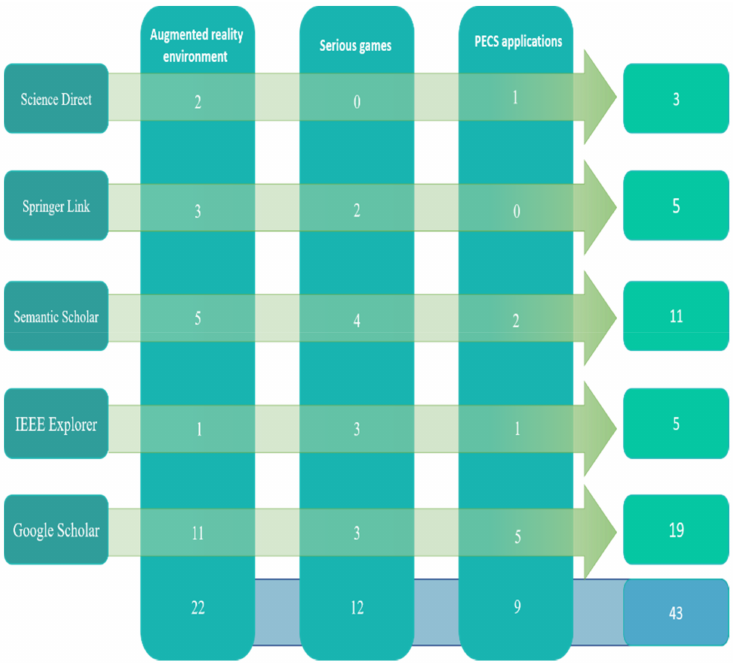
Figure 11. Filtering with Checking Inclusion and Exclusion